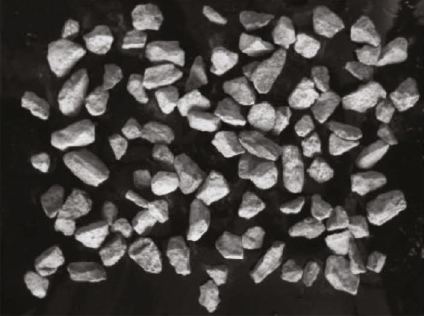
Figure 9: Wavelet reconstruction.